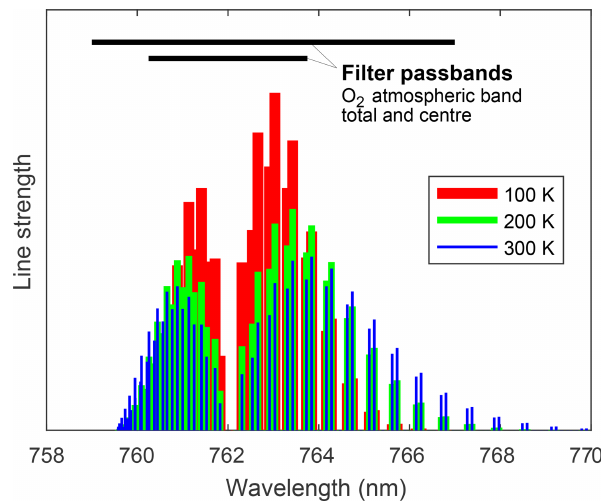
Figure 9. Spectral distribution of the O 2 atmospheric band rota- tional transitions in the 0–0 vibrational band as a function of tem- perature. The filter passbands of the limb instrument’s atmospheric band channels cover the total band and its central part,